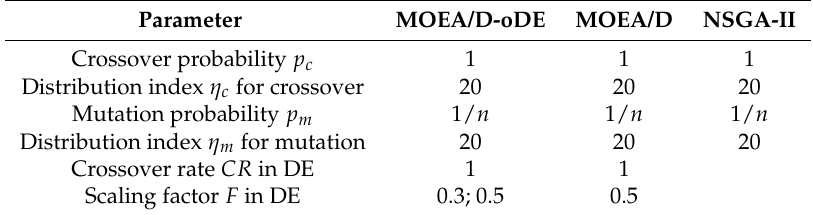
Table 1. Parameter setting in MOEA/D-optimal DE (oDE), MOEA/D and